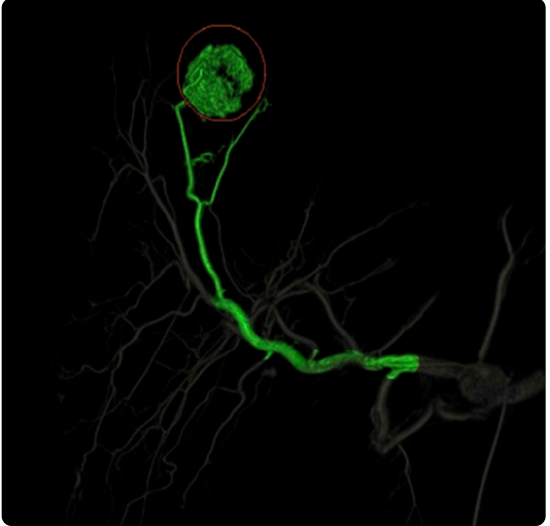
Figure 13. FlightPlan for Liver software and its role in intuitive display. FlightPlan for Liver enables the isolation of the relevant arterial vascular supply, automated vessel detection, and color coding (green) of arteries supplying the designated hypervascular region of interest. Reprinted from “Assessment of automated cone-beam CT vessel identification software during transarterial hepatic embolization: Radiation dose, contrast medium volume, processing time, and operator perspectives compared to digital subtraction angiography” by Durack et al. [78], Copyright 2018, with written approval from the corresponding author and publisher (Clinical Radiology. Copyright 2018).